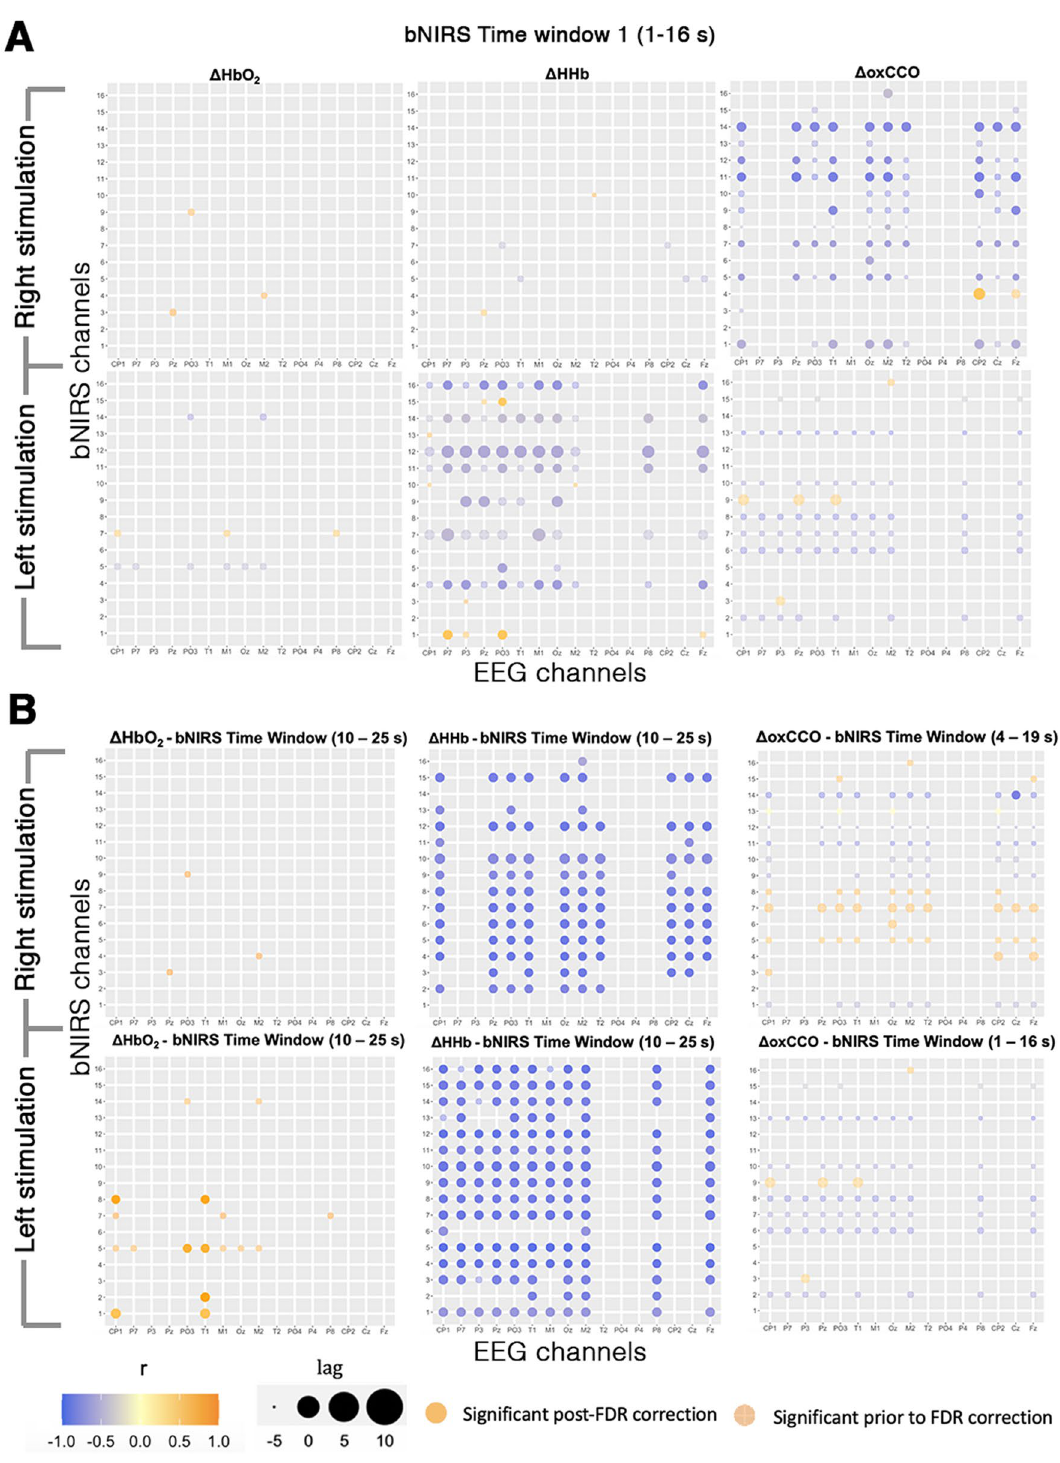
Figure 6. Cross-correlations between the EEG measure and the bNIRS signals at selected channels for ( A ) time window 1–16 s and ( B ) the time window where the maximum correlation between signals was observed, for the Right and Left Stimulation. For each bNIRS channel and EEG electrode combination, the significant maximum correlation (across subjects) is shown as colored circles with orange representing a strong positive correlation and purple representing a strong negative correlation, as shown by the color bar. On the y-axis, the bNIRS Channels 1–8 are channels over the left hemisphere and Channels 9–16 are channels over the right hemisphere. On the x-axis, EEG electrodes to the left of “Oz” (in the center of the x-axis) are electrodes over the left hemisphere and the electrodes to the right of “Oz” are electrodes over the right hemisphere. The transparent circles show correlations prior to FDR correction and the solid-colored circles indicate significance after FDR correction. The size of the circle represents the corresponding time lag with a positive time-lag indicating that EEG leads the bNIRS response. Note: The reader is advised that in the labelling of EEG channels, “T1” and “T2” do not refer to channels over the temporal cortex, rather the occipito-parietal